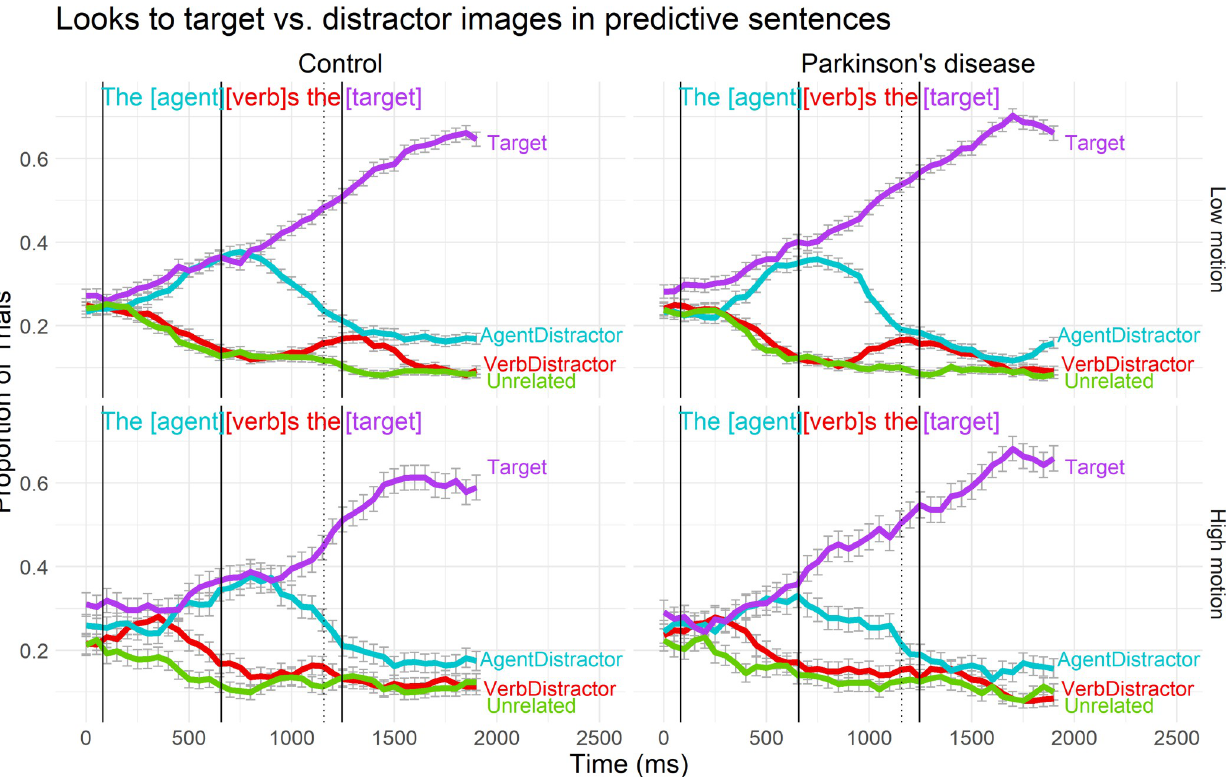
Fig 4. Gaze data by group and motion content in predictive sentences. Binned binomial gaze probabilities to each area of interest, averaged across subjects and trials over the duration of the predictive sentences for: Controls x Low motion (upper left), Controls x High motion (lower left), PD x Low motion (upper right), PD x High motion (lower right). The x-axis reflects the elapsed time in the trial in milliseconds, offset by 200ms to account for saccade programming/launching time. The solid vertical lines mark the onset of the agent, verb, and target words. The dotted vertical line marks the end of the verb statistical analysis window (which extends only partially into the post-verb article). Error bars represent standard error of the mean.